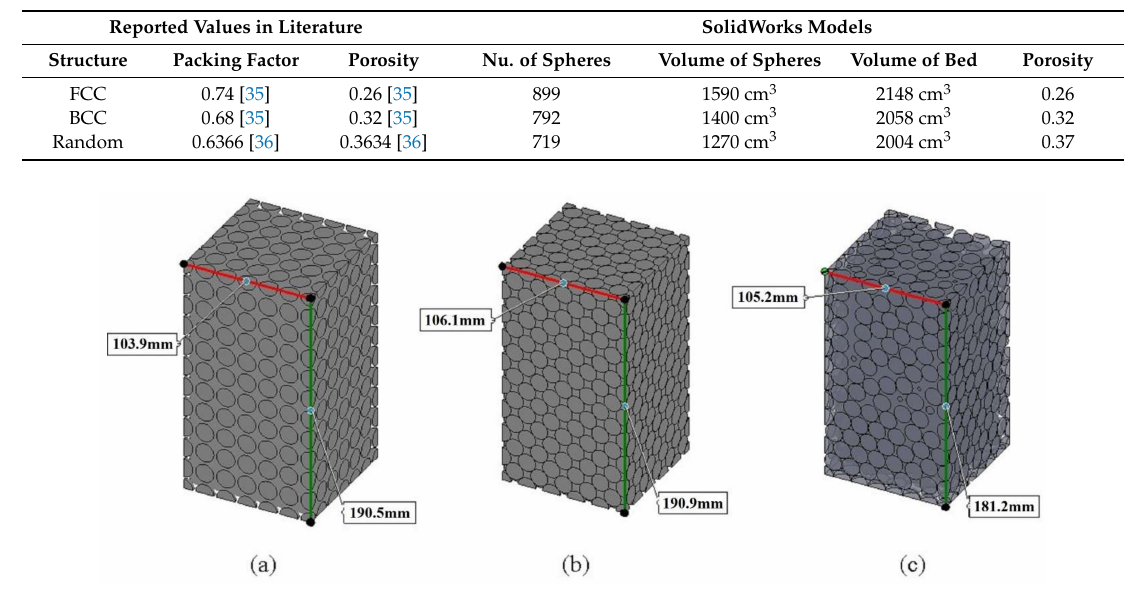
Figure 11. 3D cut models of 3 structures ( a ) BCC; ( b ) FCC; ( c )